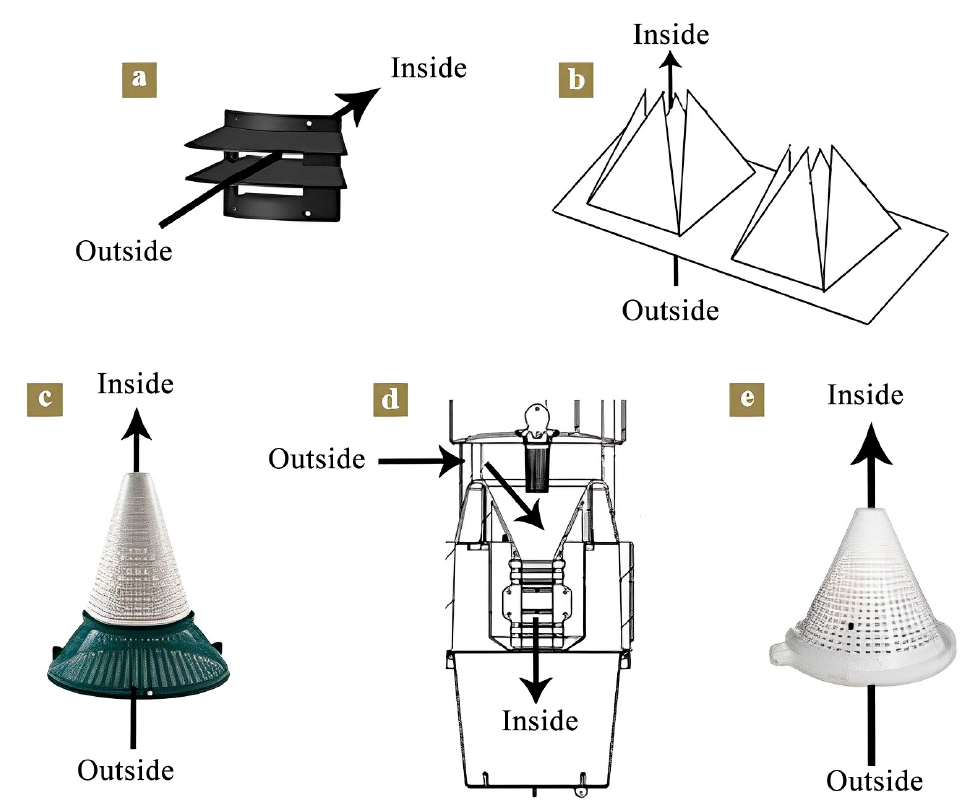
Figure 3. Insect inlet device and the entry route from the outside to the inside of five kinds of traps.